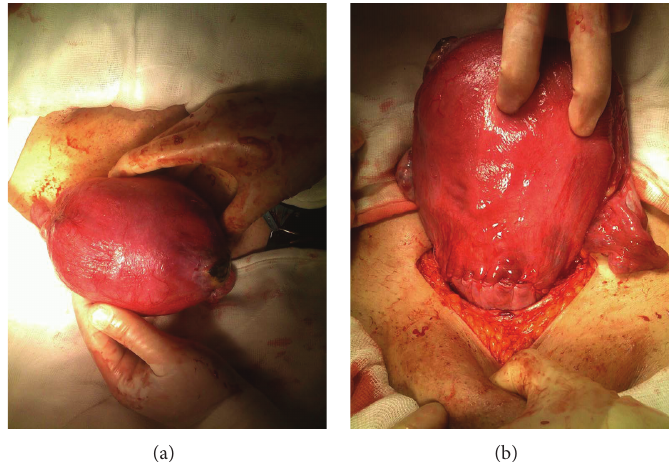
Figure 2: Stumps of right and left uterine cornua after a successful operation of caesarean